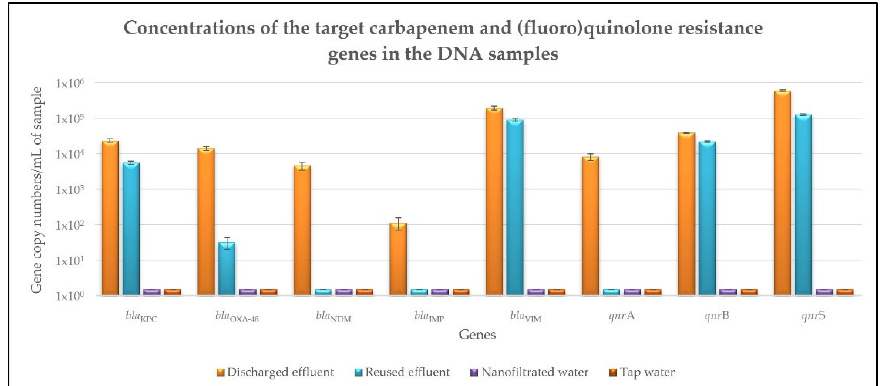
Figure 2. Concentrations of the target carbapenem and (fluoro)quinolone resistance genes in the DNA extracted from the discharged effluent, reused effluent, nanofiltered water and tap water samples. Values are expressed in gene copy numbers per milliliter and correspond to the mean ± standard deviation of biological and technical triplicates.